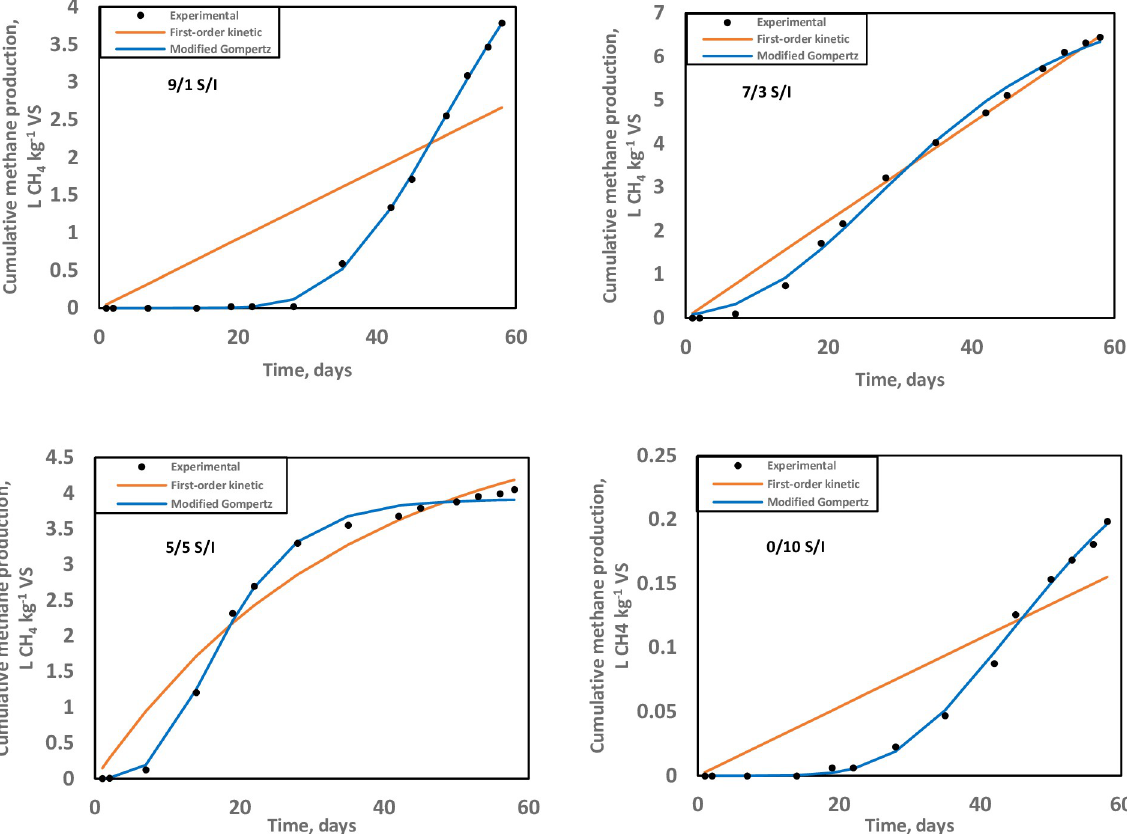
Fig 4. Simulations of the cumulative methane production, L CH 4 kg -1 VS, using the first-order regression model (orange); and the modified Gompertz model (blue).